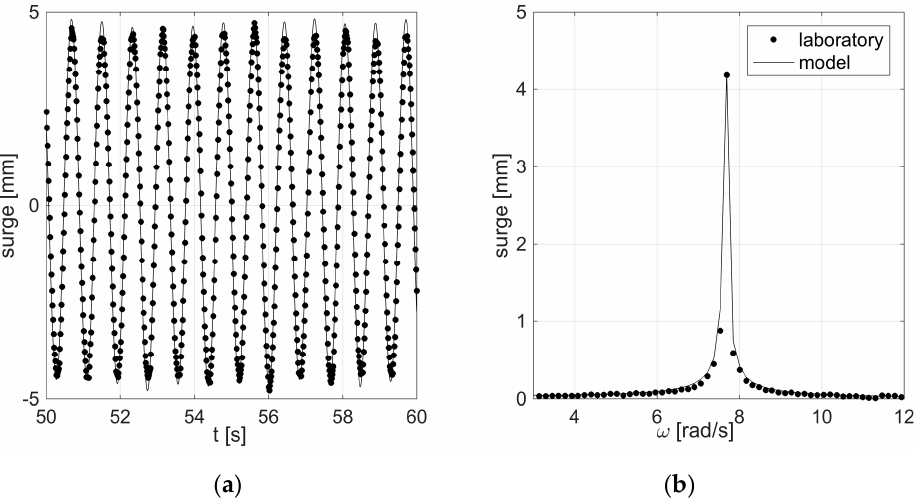
Figure 7. Surge response during test R05: comparison between laboratory and model results of the time series of oscillation ( a ) and spectrum ( b ).